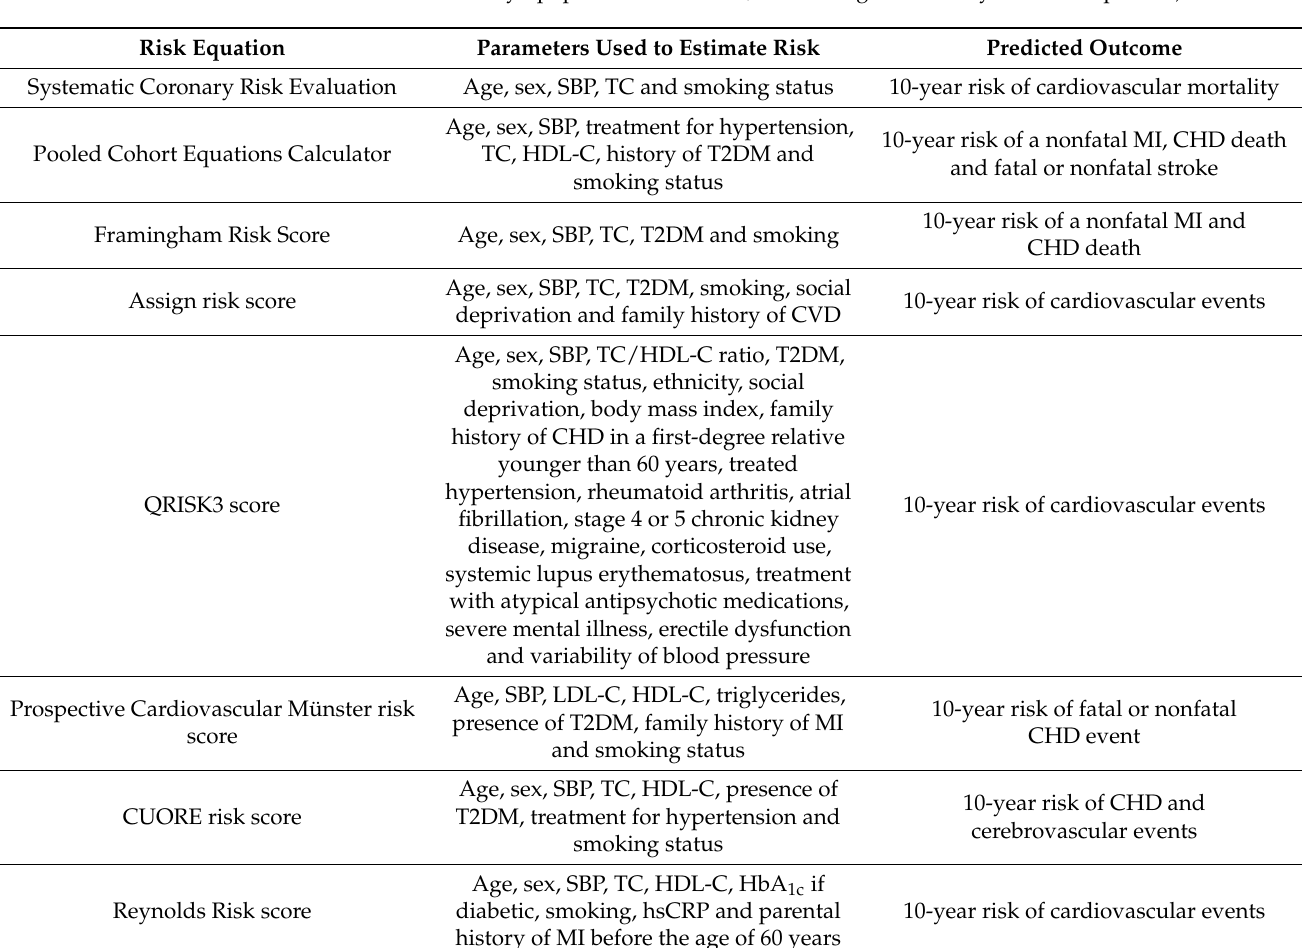
Table 1. Key characteristics of the most widely used risk prediction equations (SBP: systolic blood pressure; TC: total cholesterol; HDL-C: high-density lipoprotein cholesterol; T2DM: type 2 diabetes mellitus; MI: myocardial infarction; CHD: coronary heart disease; CVD: cardiovascular